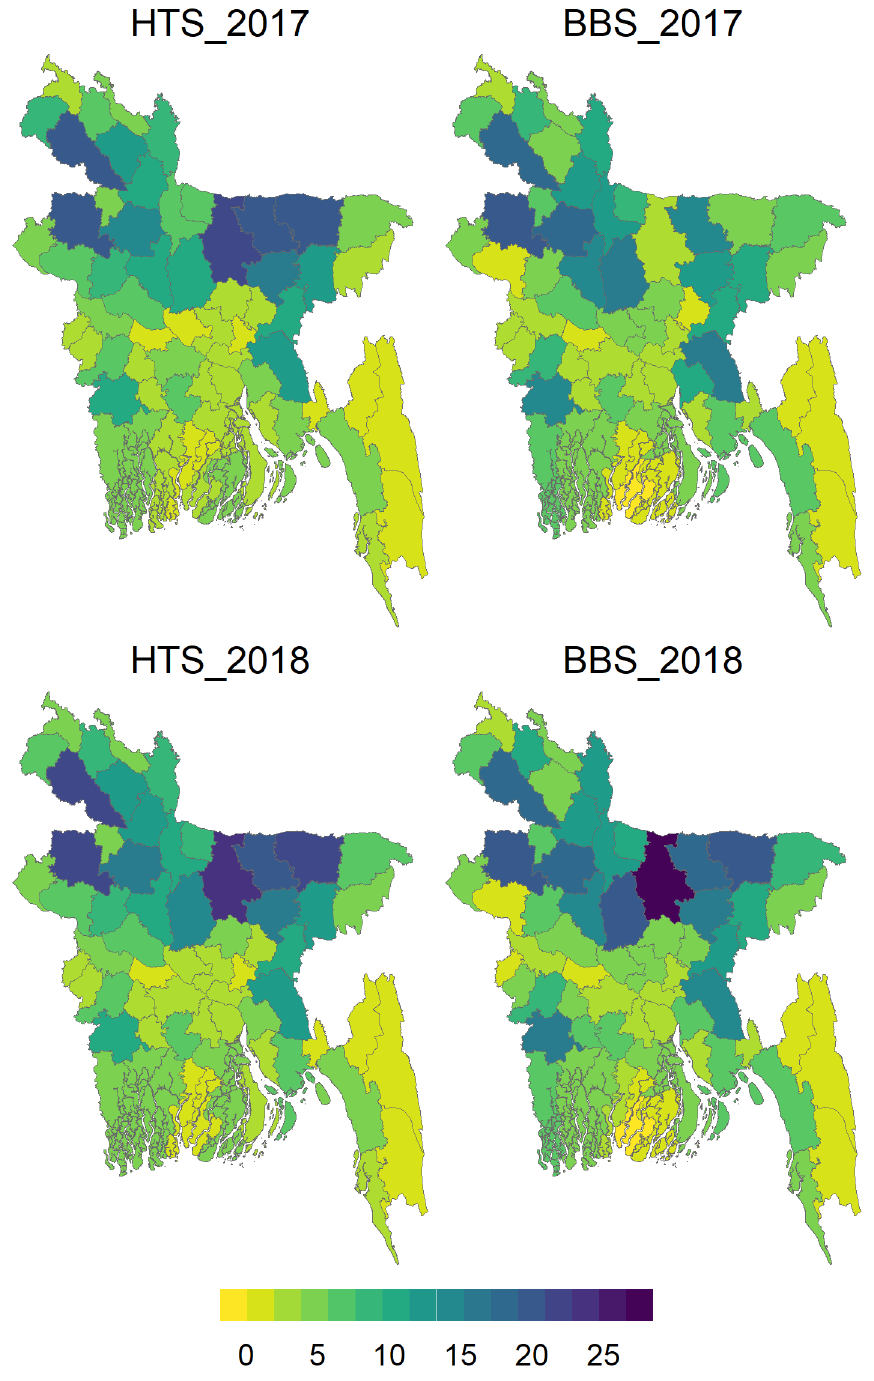
Figure 9. District-wise map of the HTS-VIs ( left ) predicted rice area compared to BBS ( right ) estimates for 2017 and 2018 (area presented in 10,000 hectares).